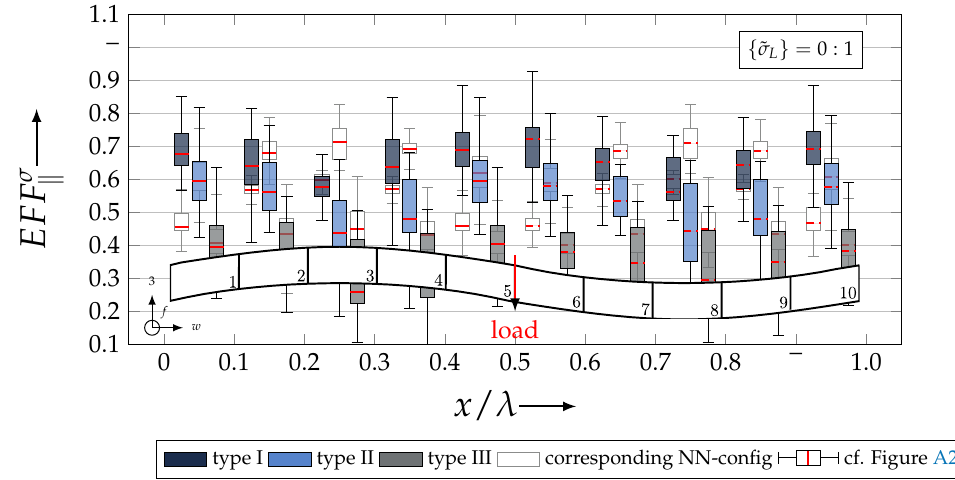
Figure 35. Comparison of EFF σ -distribution for NN and MN configs. for the triggered fracture (cid:107) resistance of the MN config., according to Equation (23) at load ratio { ˜ σ L } = 0:1 in weft